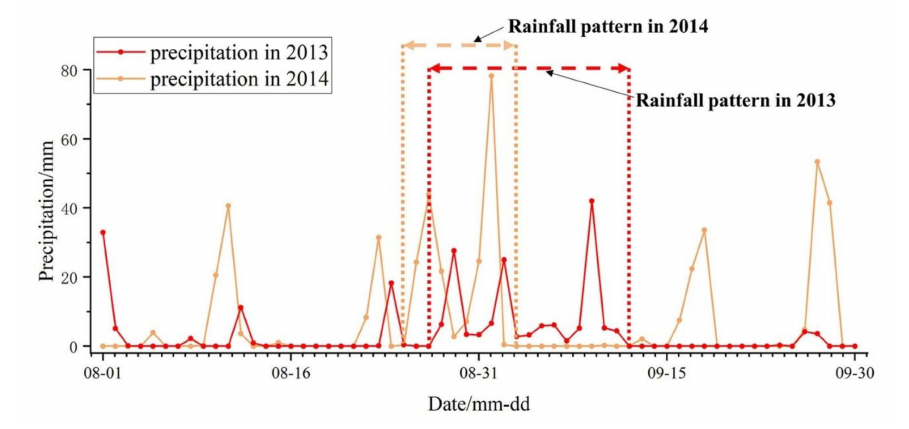
Figure 9. Precipitation from August to September in 2013 and 2014.